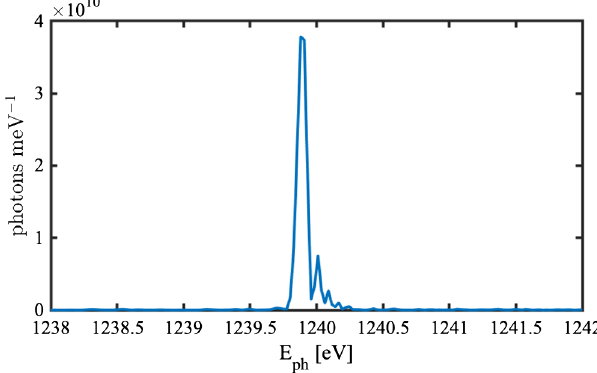
FIG. 6. SXRSS with S2E e-beam. 1 keV spectrum at the end of the undulator. The spectral behavior at 620 eV (not shown) is very similar.